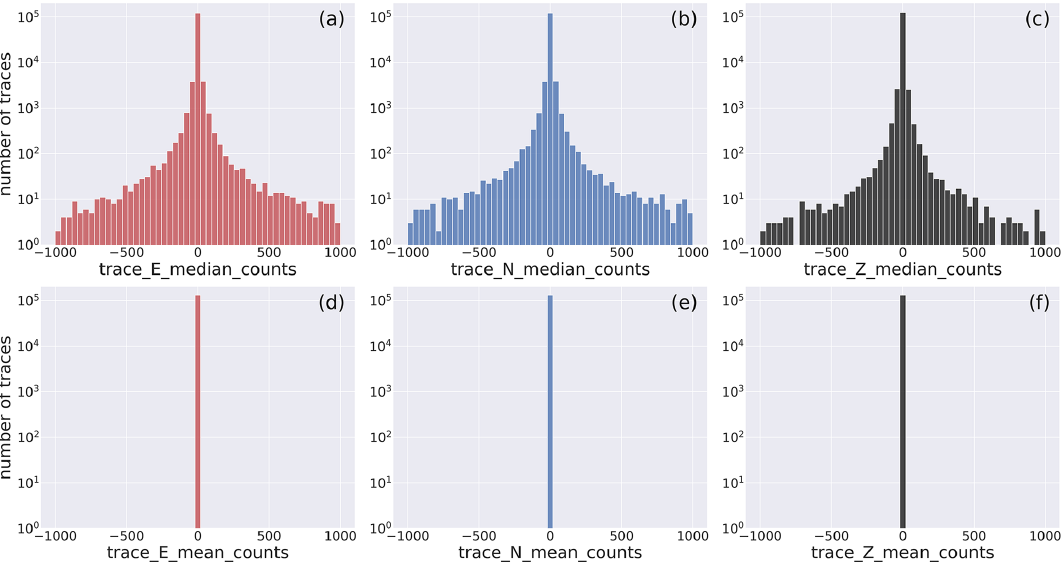
Figure D5. Histogram of the distribution of the noise quality control metadata including the full range of values attained by the median values: median (a–c) and mean (d–f) . The width of the bins is 2 × 10 3 ; axes are labeled according to the metadata listed in Table 2.